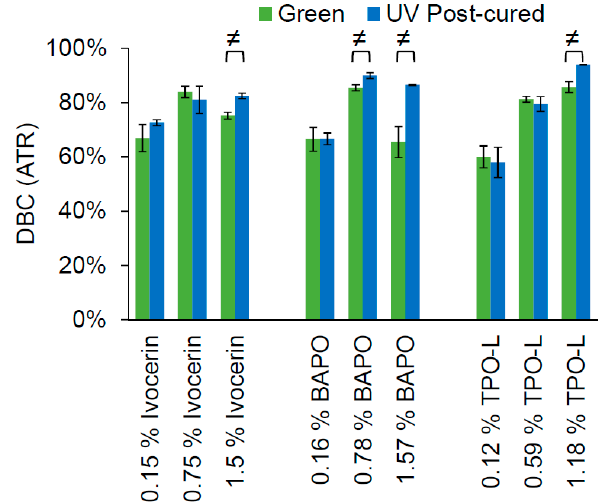
Figure 2. Double-bond conversion (DBC) of the cured specimens measured by ATR in MIR. Marks ( ≠ ) show signi fi cant di ff erence ( t -test, α = 0.05) between green and post-cured values.